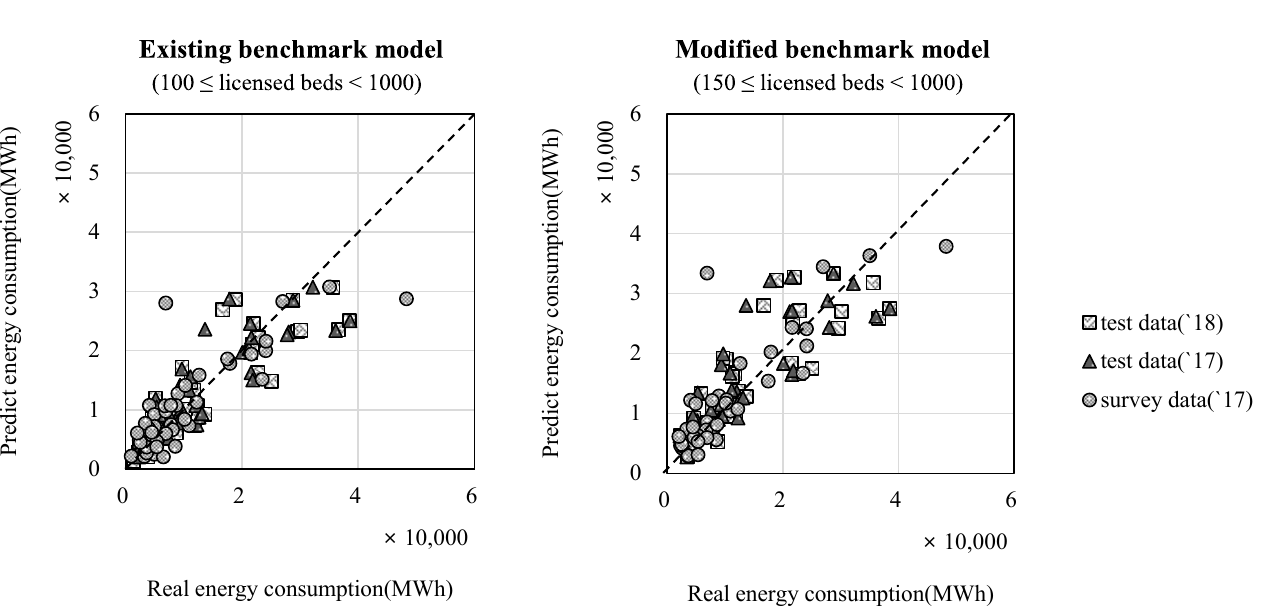
Figure 6. Real and predicted energy consumption relationship according to the benchmark model.